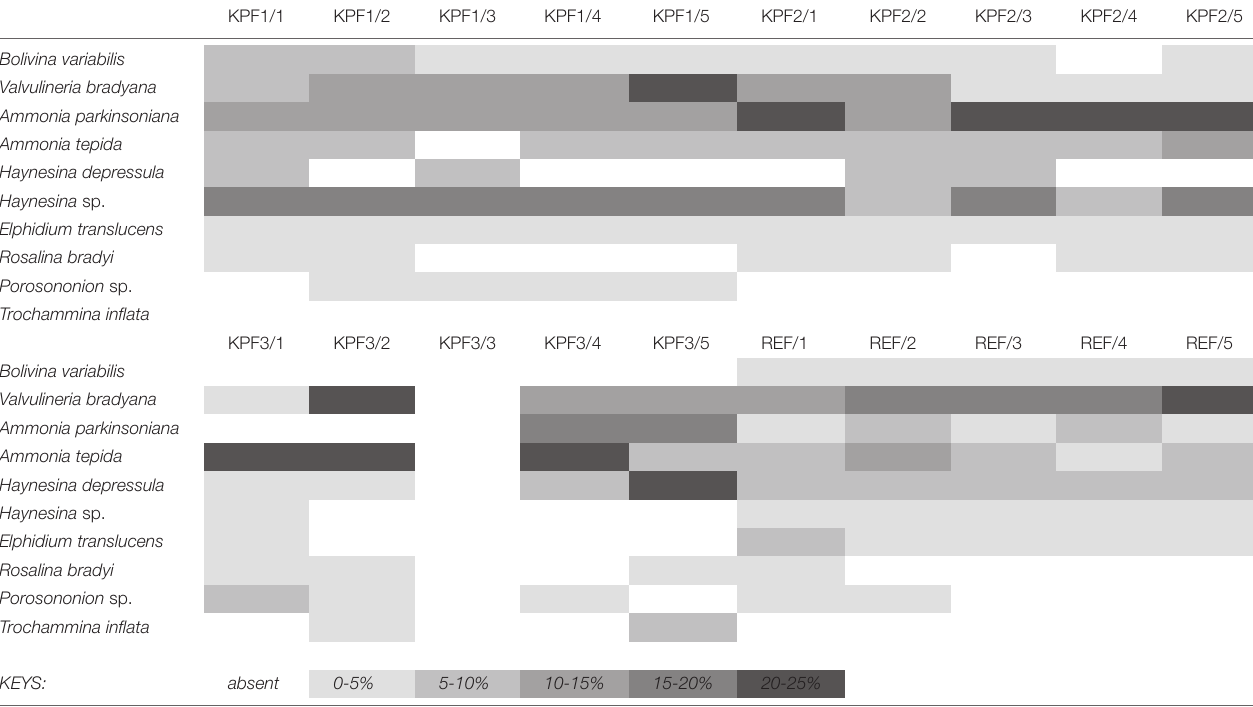
TABLE 2 | Comparative status of the abundant and common species ( > 5%) of total assemblages in at least one of studied interval and